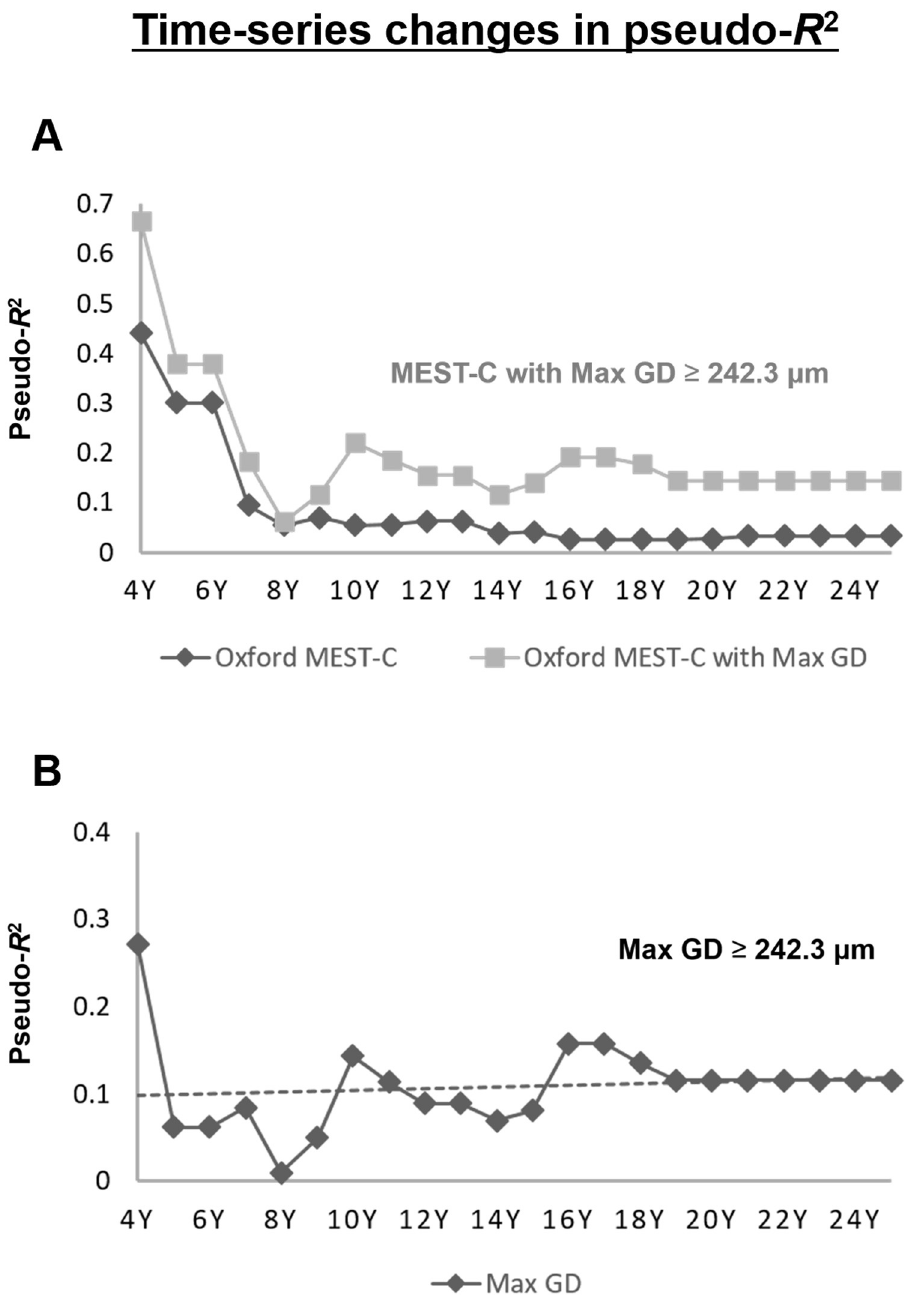
Fig 3. (A) Time-series changes in the pseudo- R 2 values of the prognostic efficacy in relation to the renal outcome. The lower line represents the time-series changes in the pseudo-R 2 values of the Oxford mesangial (M) and endocapillary (E) hypercellularity, segmental sclerosis (S), interstitial fibrosis/tubular atrophy (T), and crescents (C) (MEST-C) score and the upper line shows the time-series changes in the pseudo- R 2 values of the Oxford MEST-C score with a maximal glomerular diameter (Max GD) � 242.3 μ m. Adding the Max GD improved the model’s short-term renal prognostic ability to about 1.5-fold for patients with IgAN 4 years after kidney biopsy, and the model’s long-term renal prognostic ability to more than 3-fold for patients with IgAN at the end of the study. Max GD: maximal glomerular diameter; eGFR: estimated glomerular filtration rate; ESRD: end-stage renal disease. (B) Time-series changes in the pseudo- R 2 values for prognostic efficacy in relation to the renal outcome: Max GD. Although the prognostic potential of the Max GD tended to decrease after 4 years, it rose the predictive power with respect to renal prognosis after 8 years and sustained to the end of the study. Dotted line marks least-squares regression line. Max GD: maximal glomerular diameter.